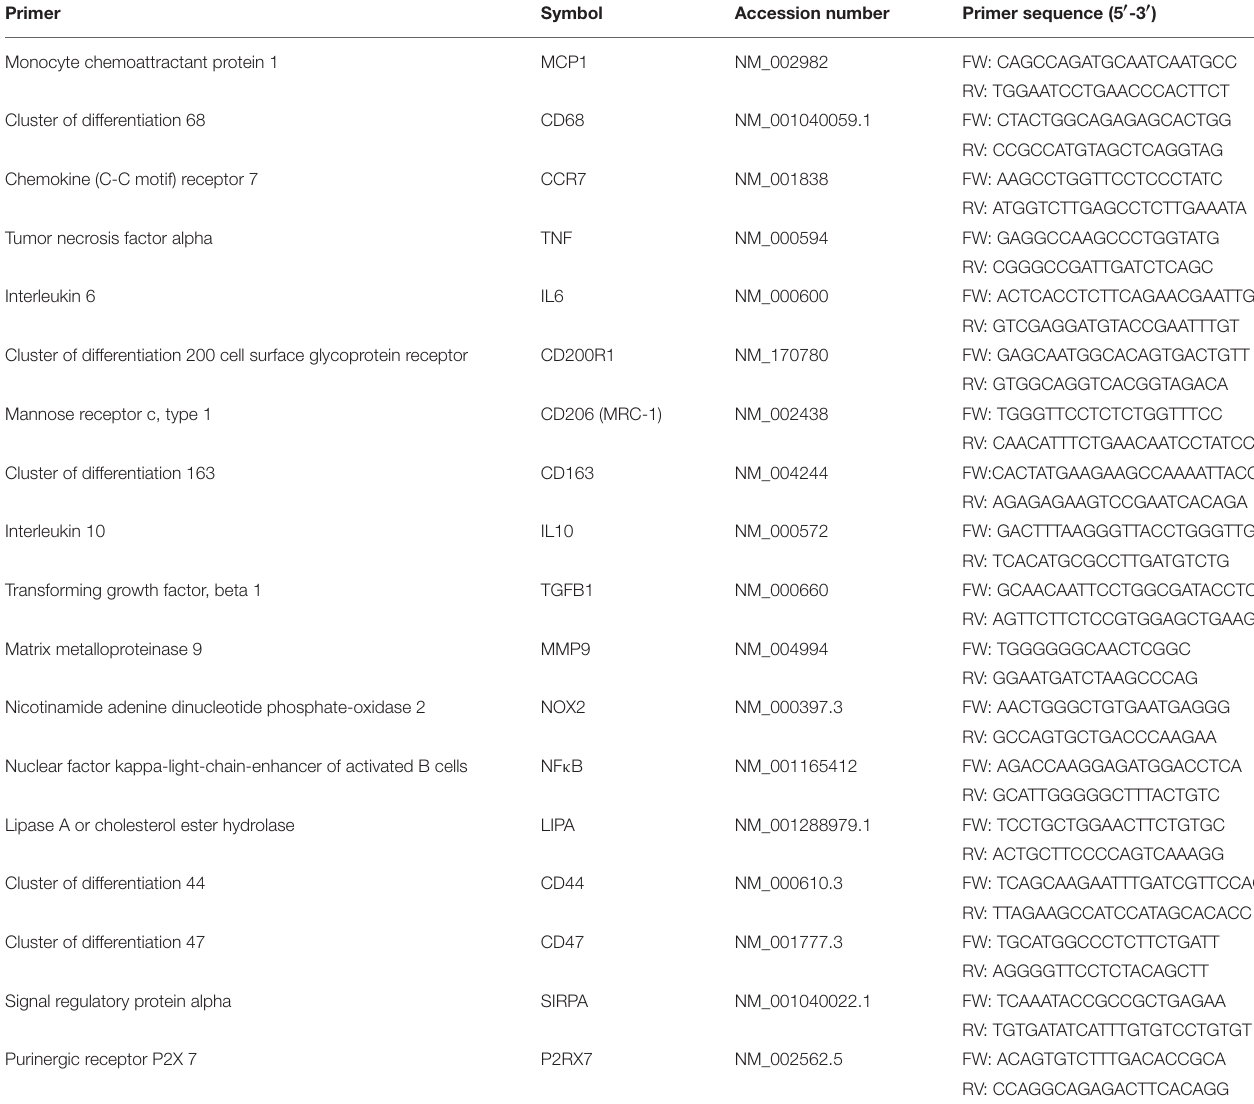
TABLE 2 | Primers for gene expression analysis. Primer Symbol Accession number Primer sequence (5 ′ -3 ′ ) Monocyte chemoattractant protein